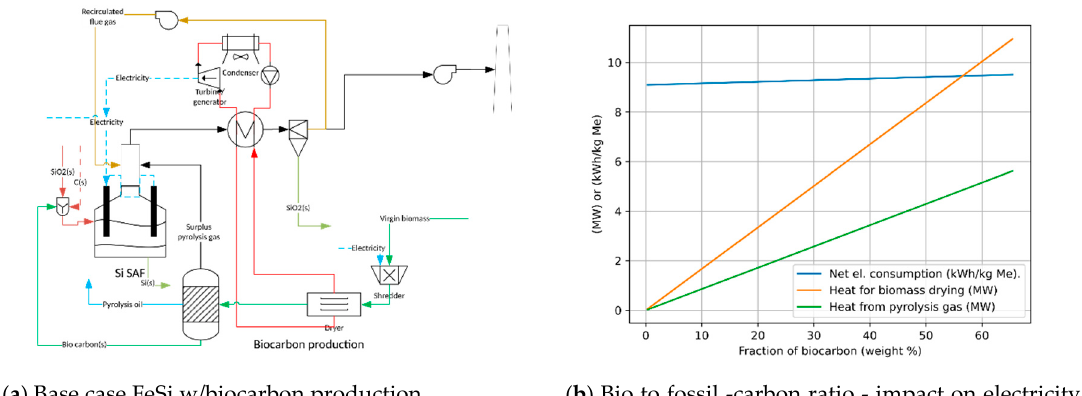
Figure 9. FeSi production with biocarbon. See Tables 2 and 3 for design parameters.